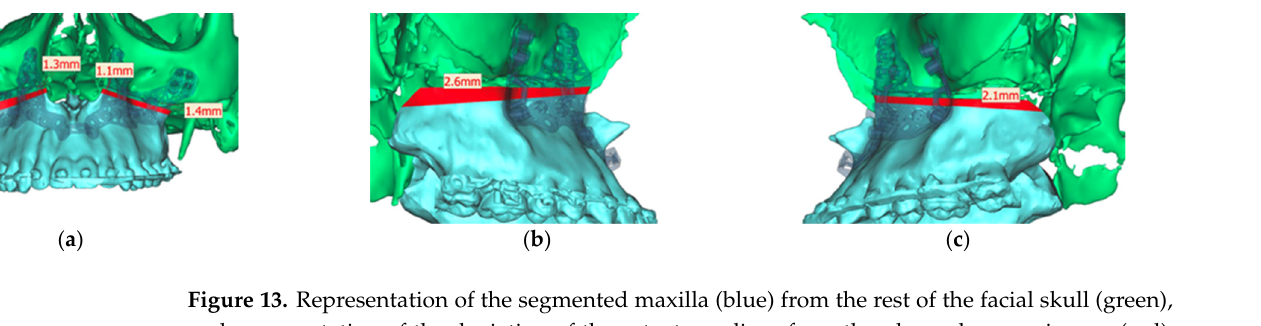
( a ) View from front ( b ). View from right ( c ). View from left. View from front ( b ). View from right ( c ). View from left.